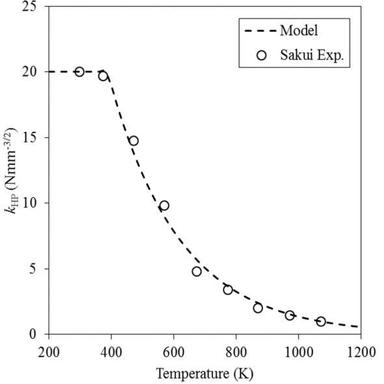
Hall-Petch term temperature dependence: two-part model compared with experimental measurements from Sakui .